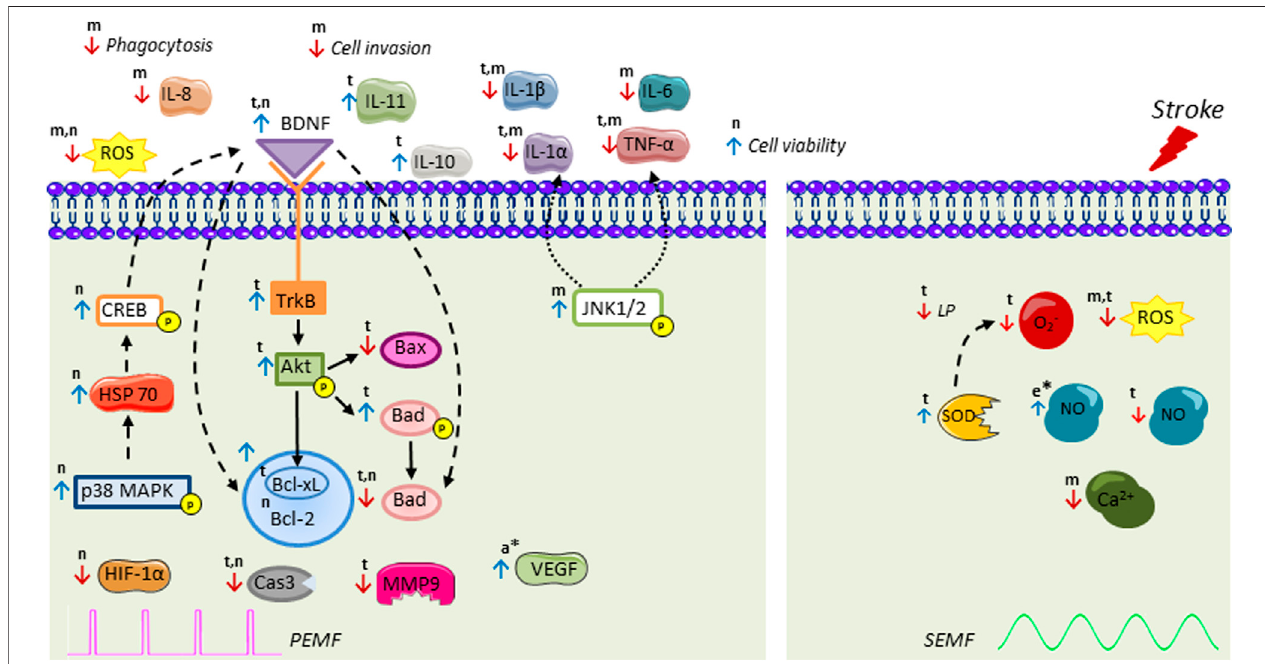
FIGURE 2 | Intracellular signal transduction cascades activated by pulsed electromagnetic fi eld (PEMF) and sinusoidal electromagnetic fi eld (SEMF) in ischemic stroke. PEMF increases activation of p38 kinase cascade, followed by HSP70, CREB, BDNF recruitment leading to an increase of antiapoptotic Bcl-2 family and decrease in apoptotic Bad.PEMFalsostimulatesBDNF/TrkB/Aktpathway,thusincreasingphospho-BadthatcannotbindtoBcl-xLanddecreasingBax,Bad,andCas3.PEMFdecreasesMMP9,HIF- 1 α , ROS, and proin fl ammatory interleukins and upregulates anti-in fl ammatory IL-11 and IL-10. PEMF-induced downregulation of TNF- α and IL-1 β is possibly mediated by JNK1/2. The molecular mechanisms of SEMF have been less studied. PEMF also exerts regulation on endocannabinoid system (AEA, 2-AG, MAGL, DAGL, NAPE-PLD, FAAH) withERK signalingasan essentialdownstream mechanism. SEMFdecreasessuperoxide(O 2 − ), intracellularCa 2+ ,ROS,NO, and LPlevel, whileitincreases SODandNOlevels. Results have been assessed in t, brain tissue; n, neuron-like; m, microglia; a, astrocytes; and e, endothelial cells. * indicates only EMF stimulation without stroke. BDNF: brain- derivedneurotrophicfactor;CREB:cAMPresponseelement-bindingprotein;HSP70:heat-shockproteinsof70;Akt:proteinkinaseB;TrkB:tropomyosin-relatedkinaseB;ROS: reactiveoxygenspecies;HIF-1:hypoxia-inducedfactor1;Cas3:Caspase-3;MMP9:matrixmetalloproteinase9;IL:interleukin;TNF- α :tumornecrosisfactor α ;JNK1/2:c-Jun-N terminal kinase; SOD: superoxide dismutase; NO: nitric oxide; LP: lipid peroxidation; VEGF: vascular endothelial grow factor; AEA: N-arachidonylethanolamide; 2-AG: 2- arachidonoylglycerol; DAGL: diacylglycerol lipase; MAGL: monoacylglycerol lipase; NAPE-PLD: N-acyl phosphatidylethanolamine phospholipase; FAAH: fatty acid amide hydrolase. Figure was created using Servier Medical Art